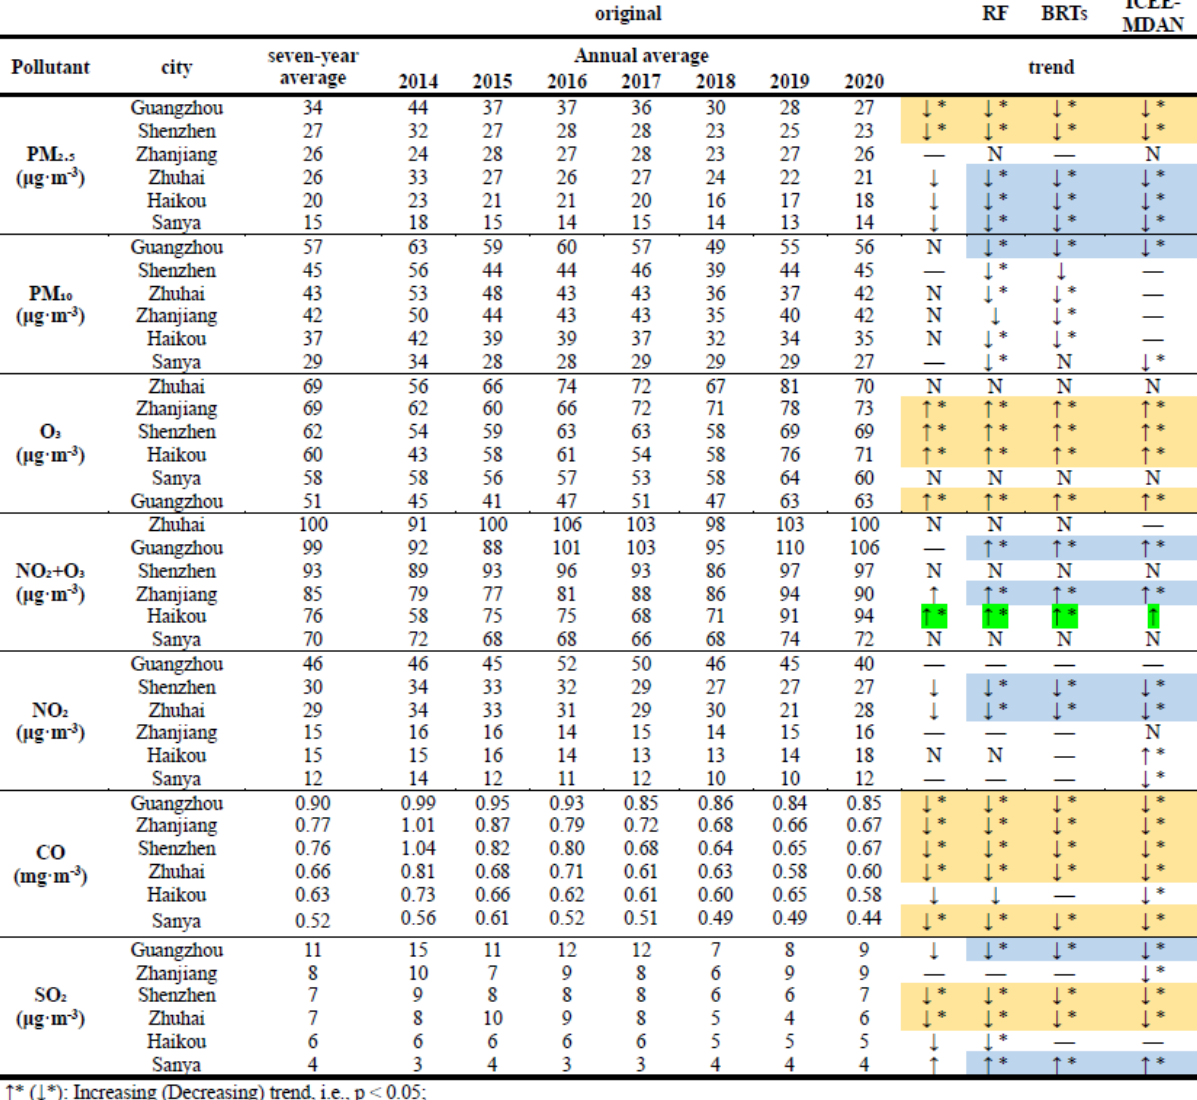
Table 1. The original annual average concentrations of six criteria air pollutants and NO 2 + O 3 and their trends in original annual averages, RF-deweathered and BRT-deweathered concentrations and ICEEMDAN-decomposed residuals in six cities detected by the M–K method. Yellow represents four consistent increasing or decreasing trends, blue represents consistent trends detected only from three methods, green represents consistent trends in original and two machine learning methods.